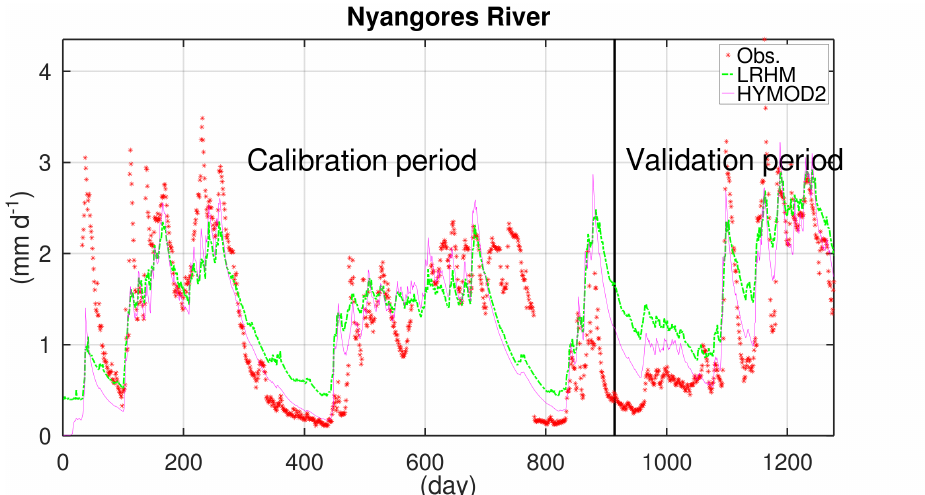
Figure 5. Application of LRHM and HYMOD2 in Nyangores River. Validation and calibration periods refer to the corresponding periods of the hydrological